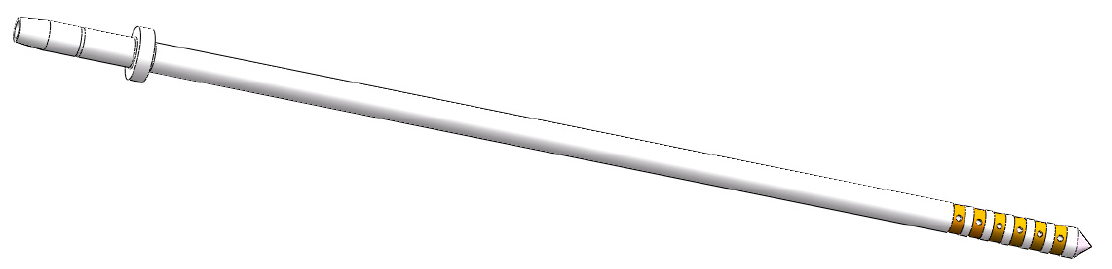
Figure 4. The probe.